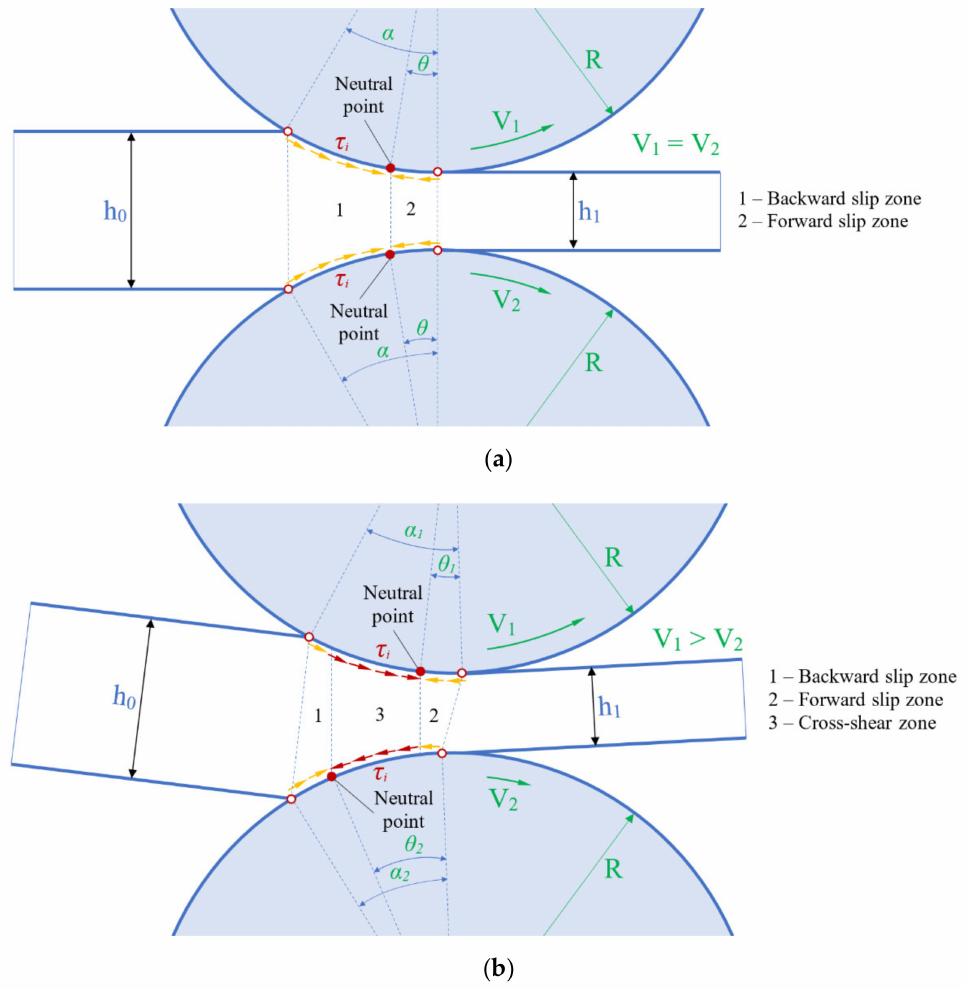
Figure 16. Schematic illustration of deformation zone during symmetric ( a ) and differential speed rolling ( b